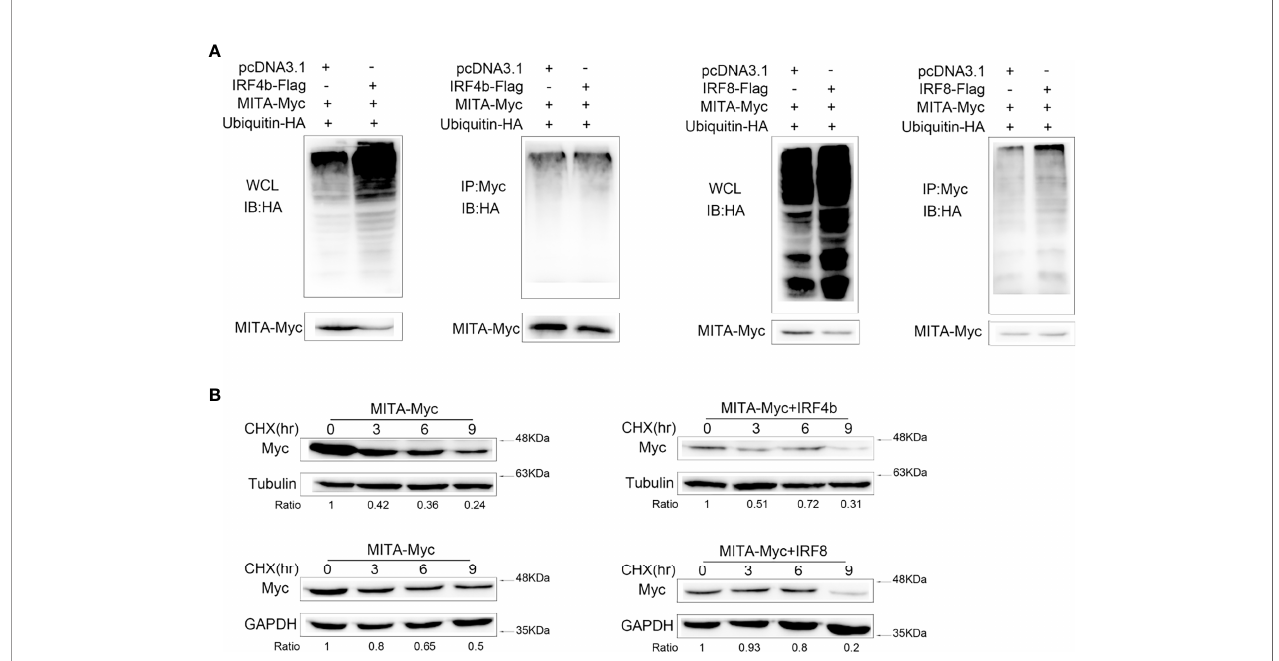
FIGURE 7 | IRF4 and IRF8 lead to the elevation of MITA polyubiquitination and shorten its half-life. (A) HEK293 cells were seeded on 10 cm 2 dishes and cotransfected with MITA, ubiquitin-HA, and IRF4b or IRF8, and the plasmids were all used in 2 m g doses except for ubiquitin-HA which was in 1 m g. At 24 h posttransfection, the cells were treated with MG132 for 10 h, and the cells were lysed to conduct IP assays with Myc antibody and immunoblot assays with antibody against HA. The samples from the immunoprecipitates and whole cell lysates (WCL) were analyzed by immunoblot assays, taking the results from WCL as controls. (B) MITA and IRF4b or IRF8 were transfected into EPC cells which were treated with CHX (100 µg/ml) at 24 h after transfection. The dose was always 0.4 m g per plasmid. After cells were lying at different time points, immunoblot assays were performed to examine the expression of MITA. All the experiments were performed independently at least three